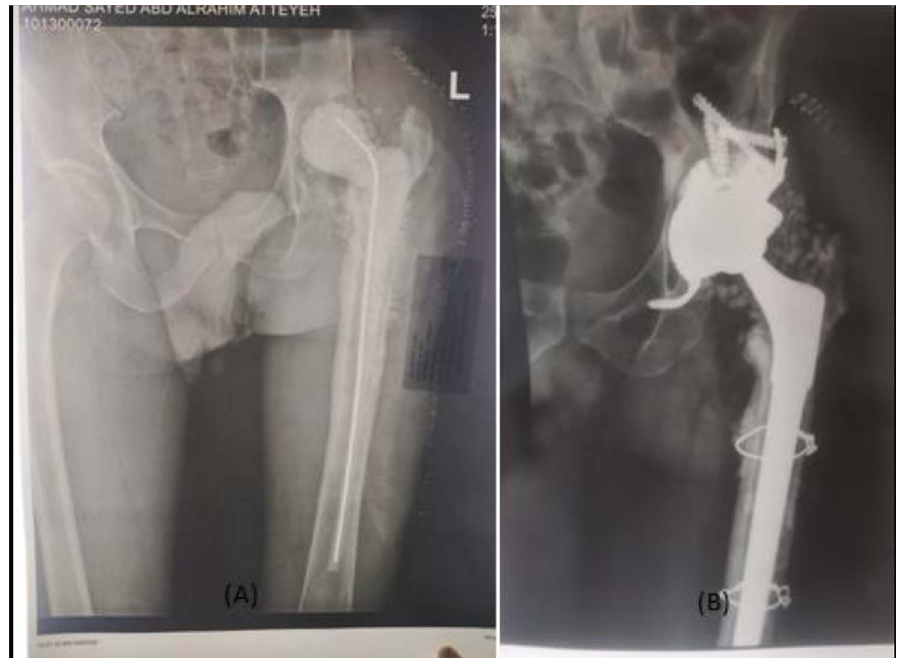
Figure 4. (A) preoperative X-ray for a case with hip spacer and acetabular defect, (B) postoperative X-ray after reconstruction using Delta TT revision system.